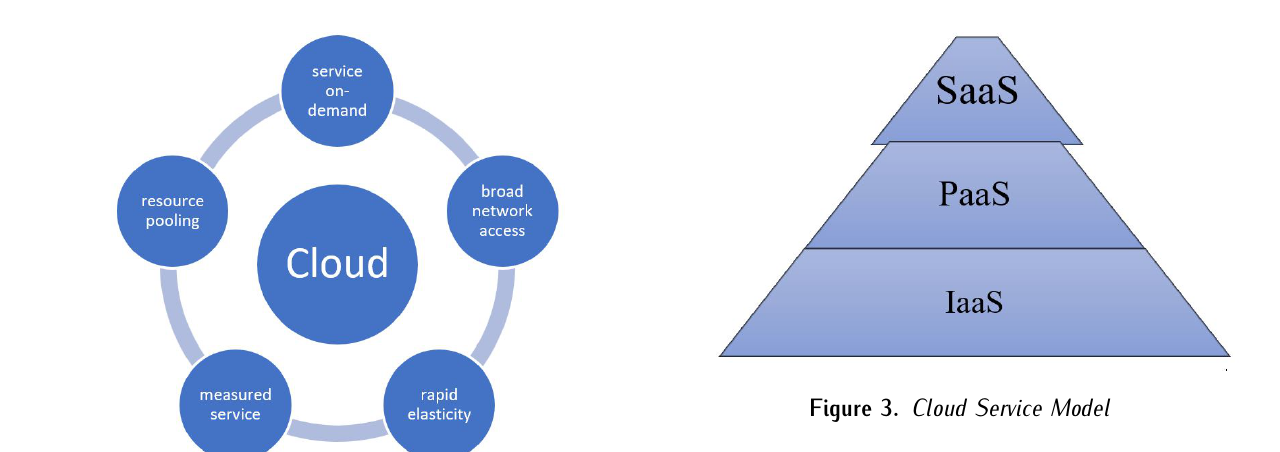
Figure 3. Cloud Service